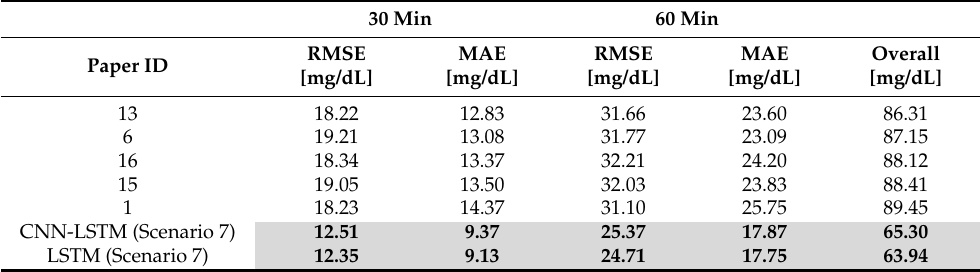
Table 6. Comparison of our results and the top five ranked research works that participated in the 2020 BGLP challenge. Population mean ± (standard deviation) of accuracy metrics (MAE and RMSE) for 30 and 60 min ahead BG prediction. 30 Min 60 Min Paper